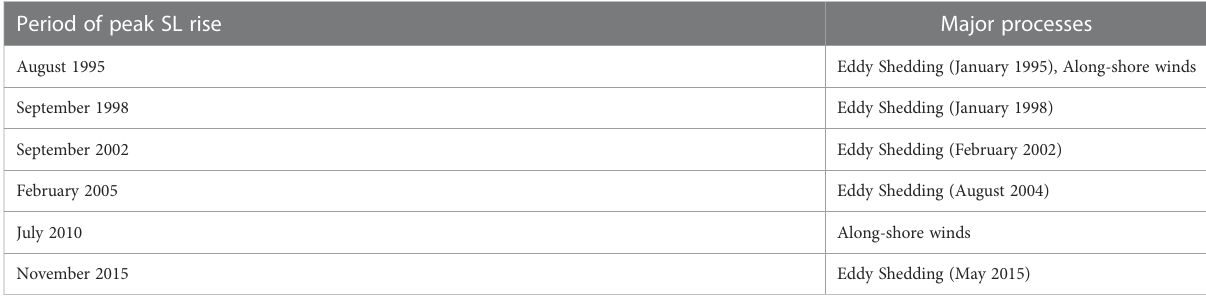
TABLE 1 Periods of extreme SL rise events and associated major